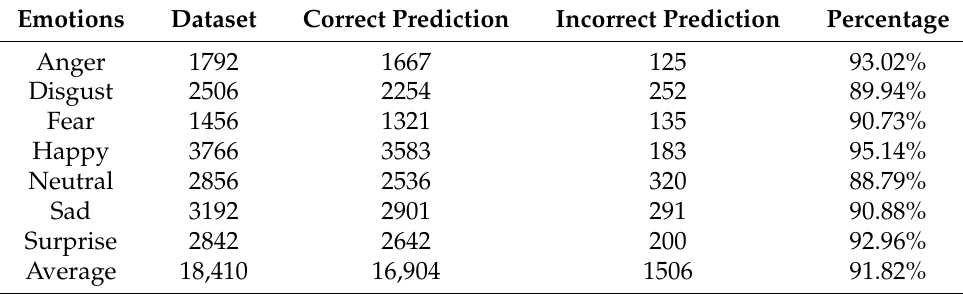
Table 12. Test result with prediction detail of Model 1 after 100 epochs.